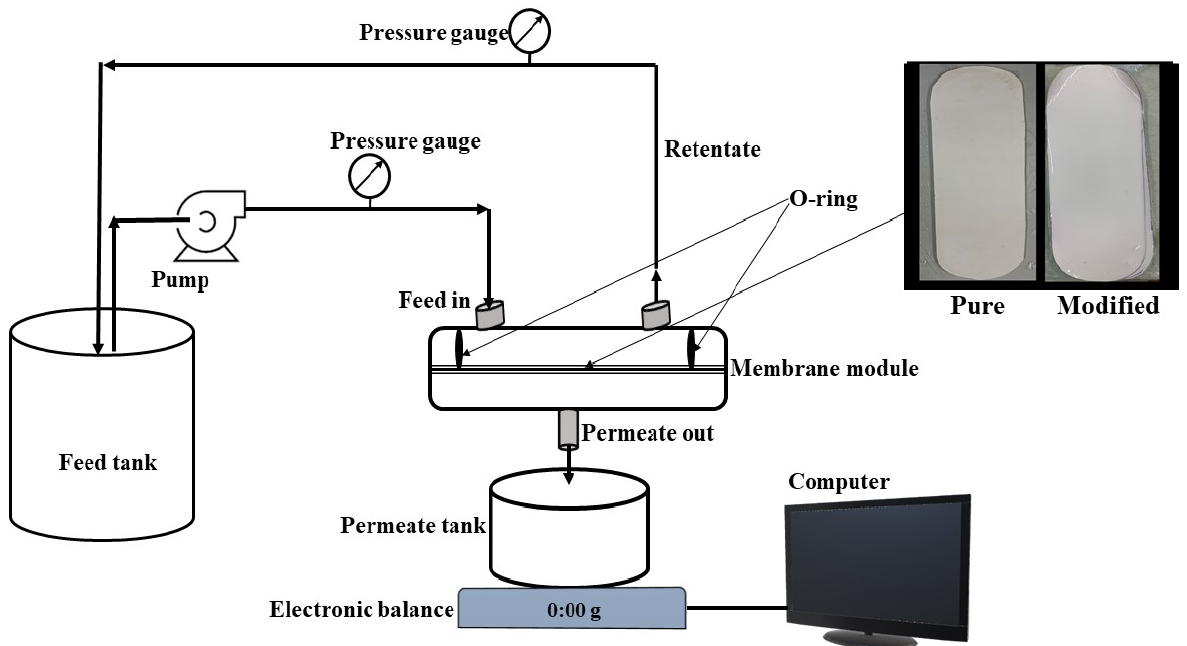
Figure 2. Schematic representation of the cross-flow filtration unit.